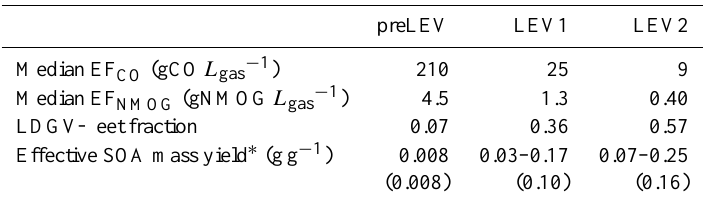
Table 7. Median emission factors and SOA mass yields reported in Gordon et al. (2013). These values include products of incomplete combustion and products of incomplete catalytic converter